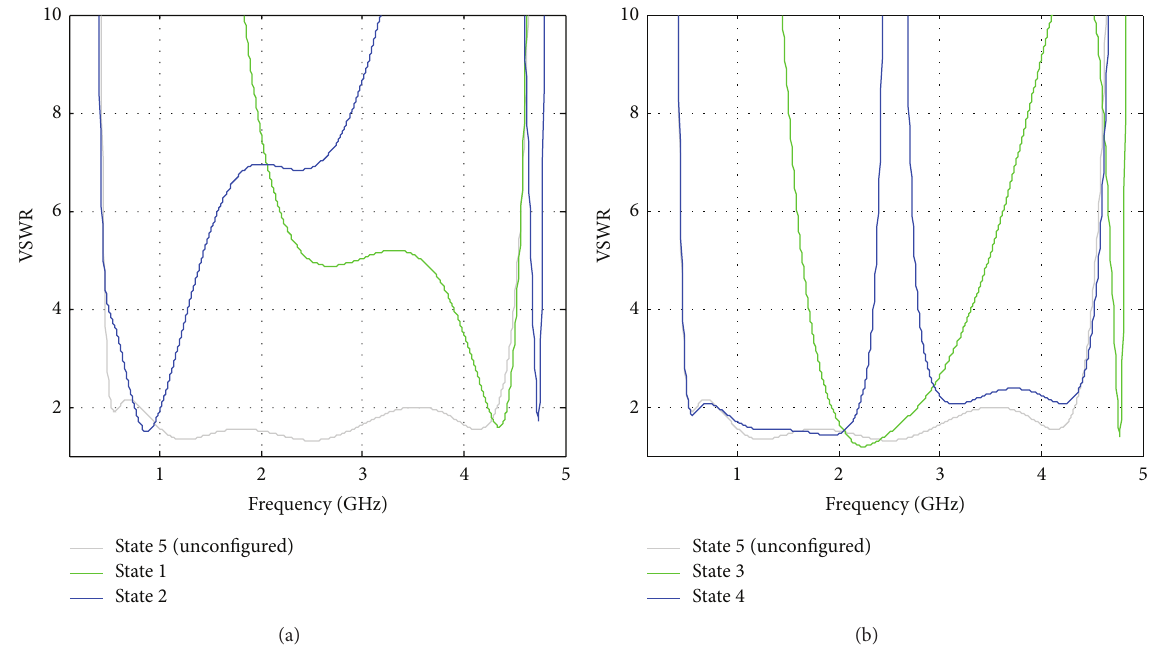
Figure 21: VSWR versus frequency for Table 2 reconfiguration